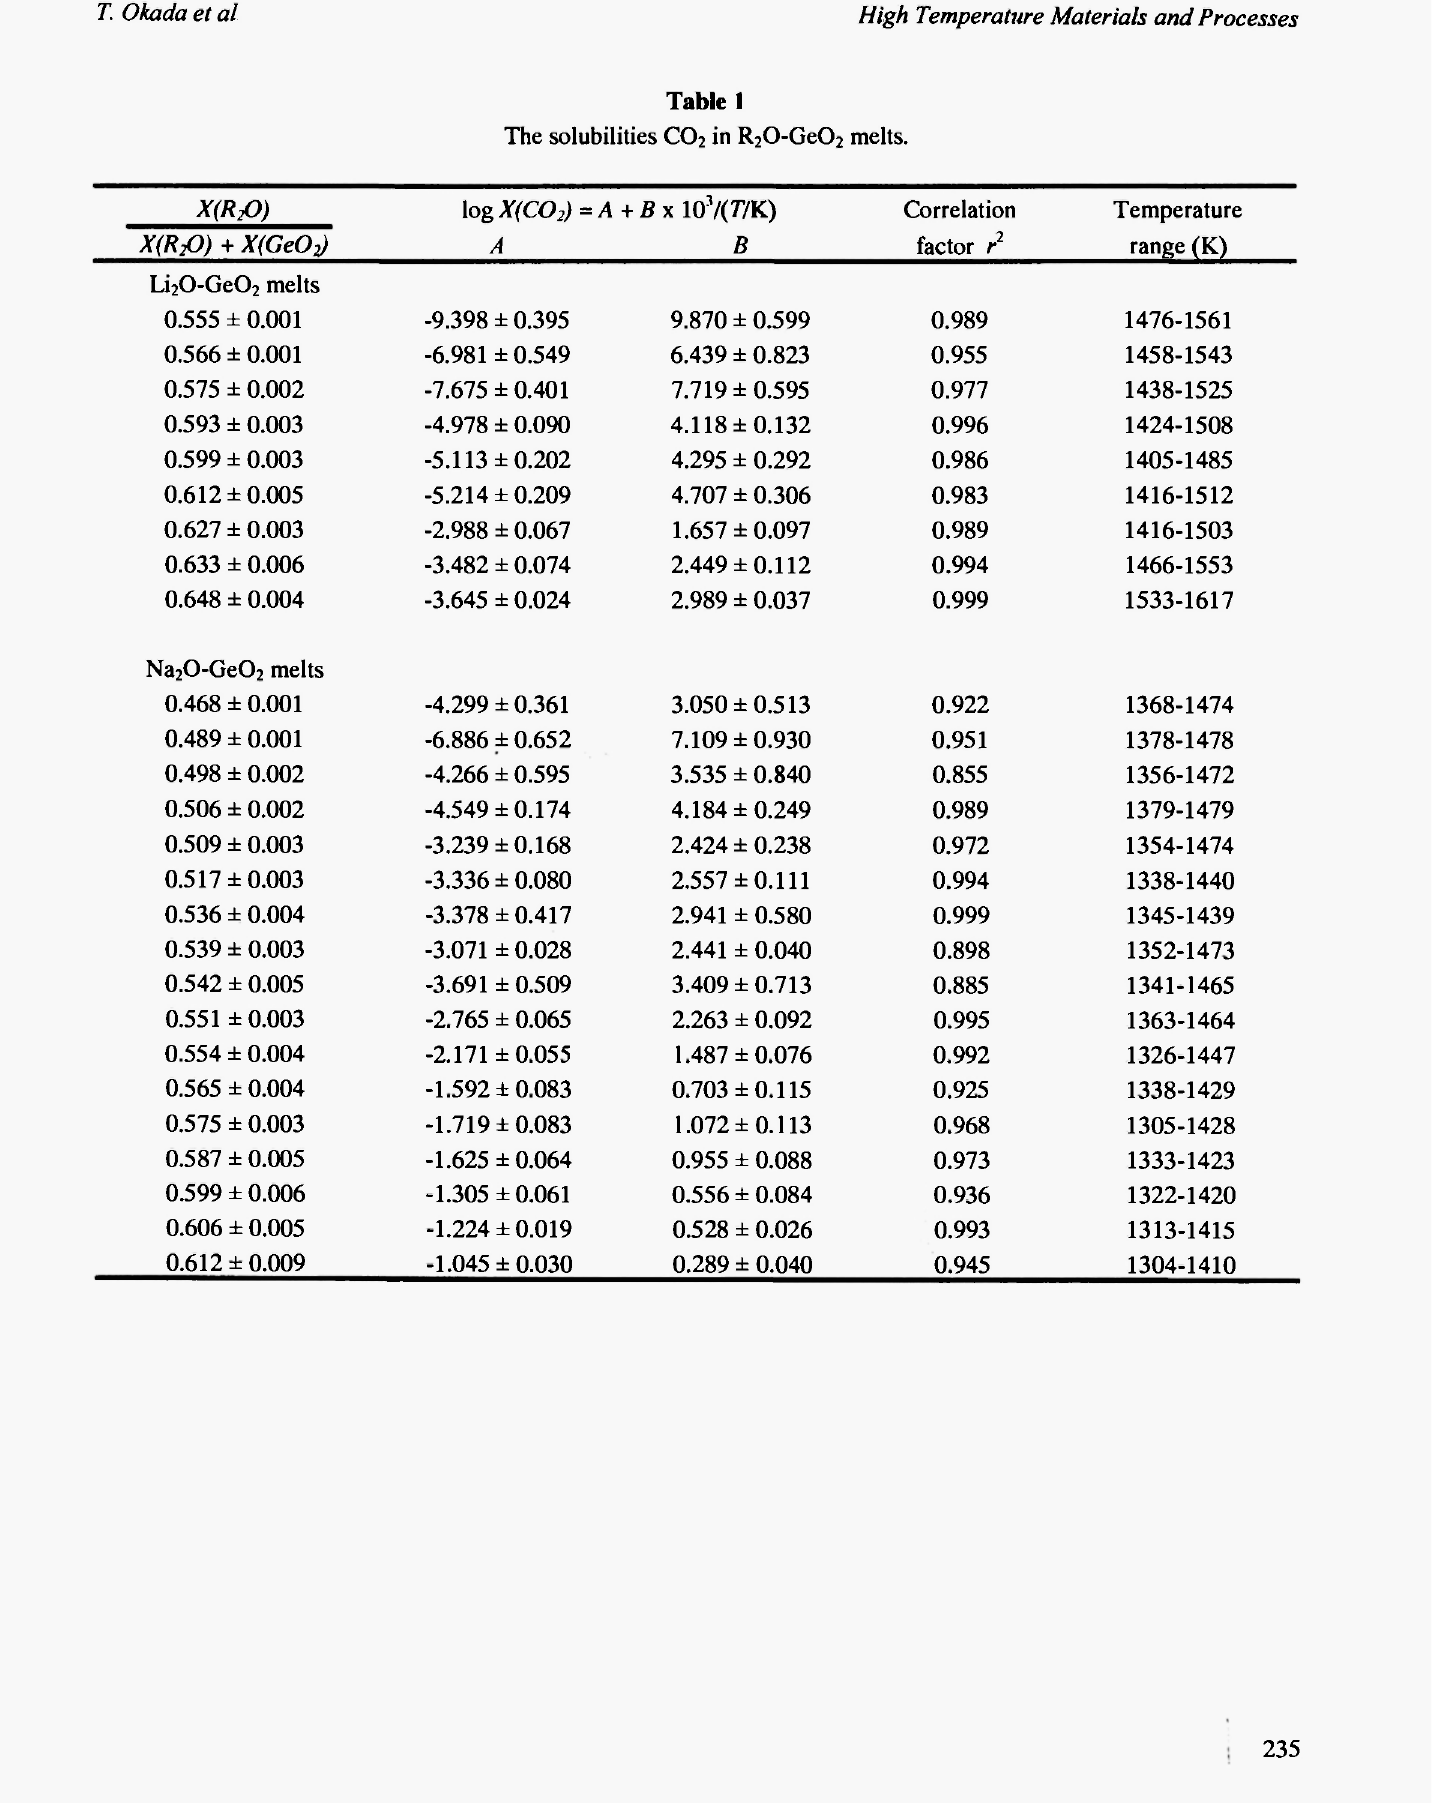
The solubilities C0 2 in R 2 0-Ge0 2